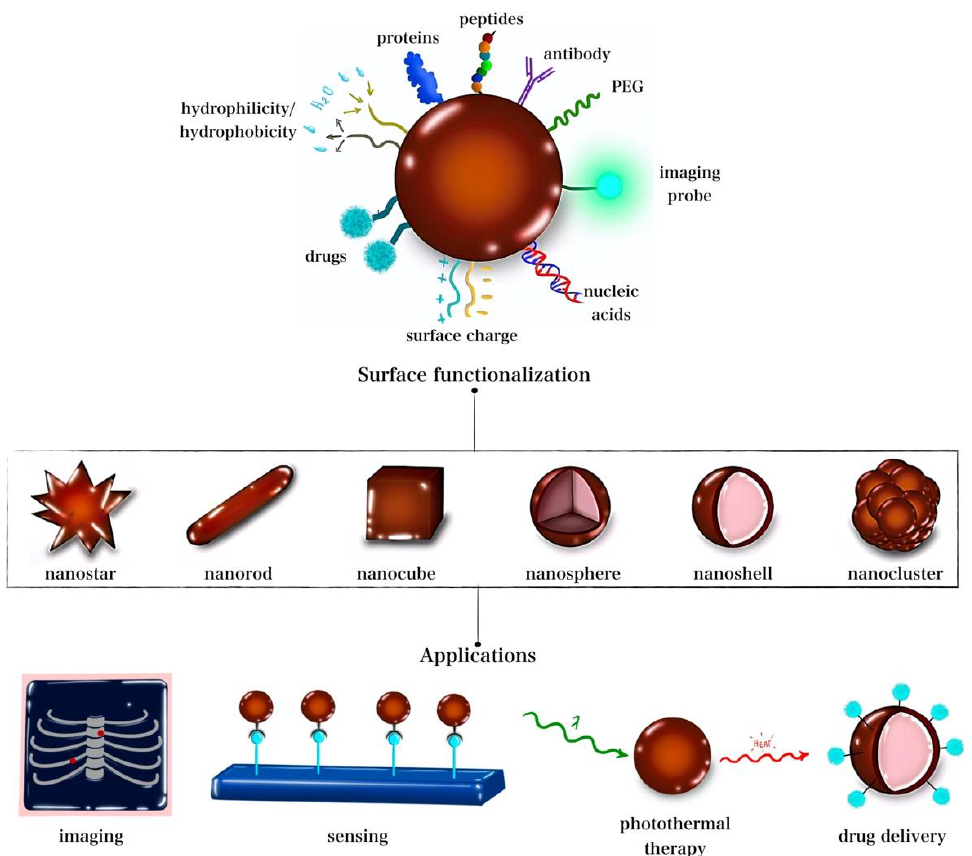
Figure 1. GNP hybrid nanostructures shapes, functionalization, and common applications.